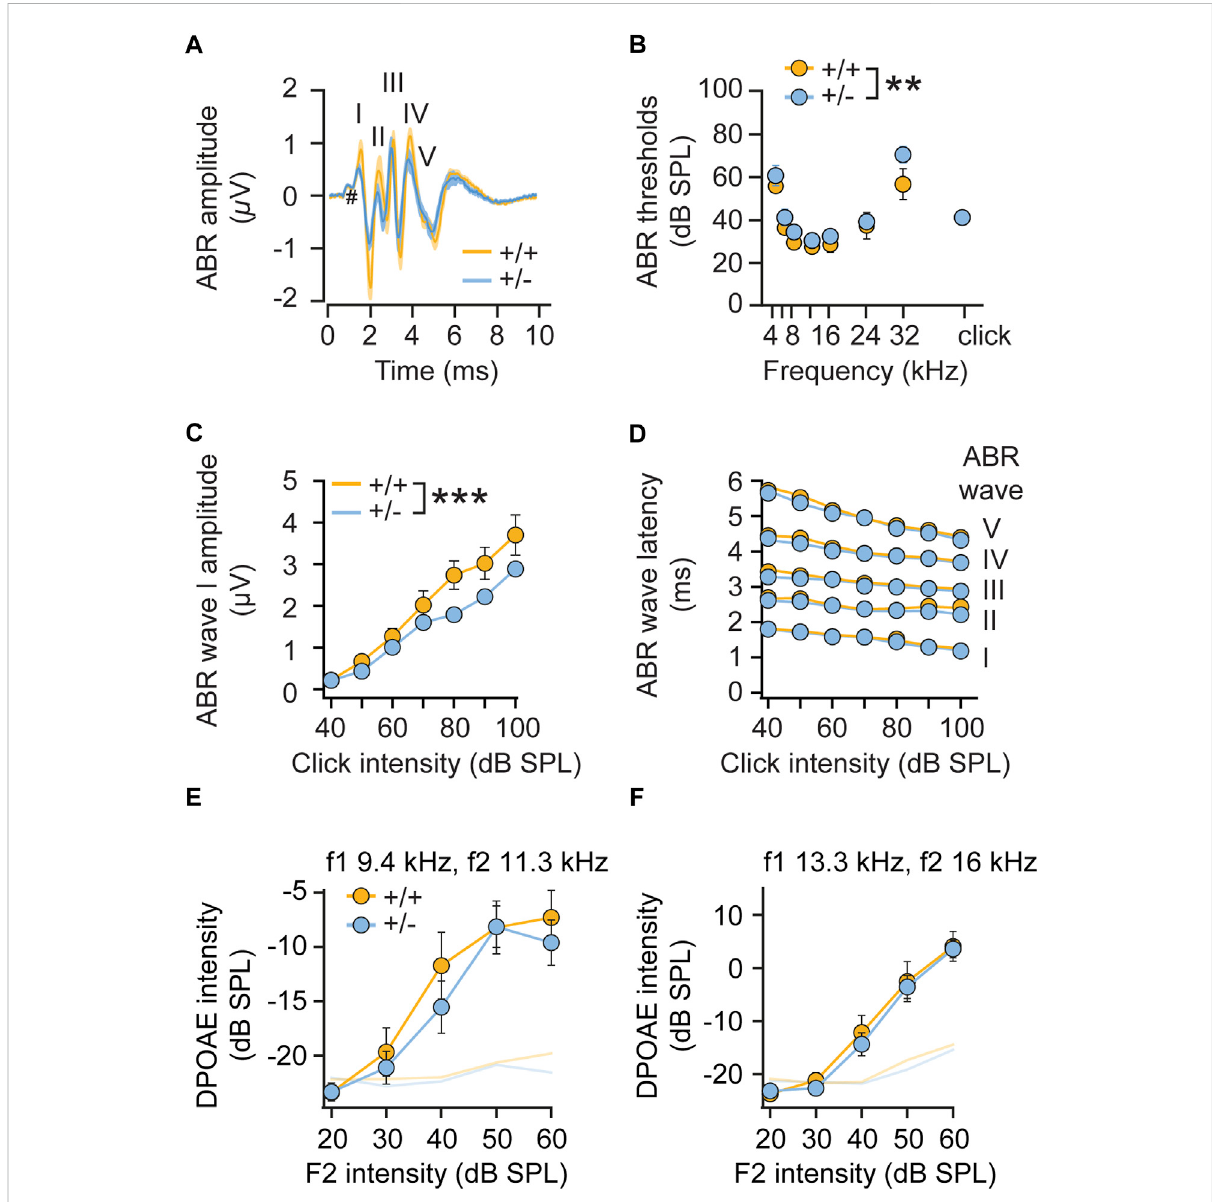
Monoallelic loss of radixin only minimally affects hearing function. (A) ABR waveforms to a 80-dB click stimulation in adult (+/+) and (+/-) rdx mice(grandaverages±SEM, n =10each)arewellpreserved.RomannumeralsontopdesignateABRwaves;#indicatesthesummatingpotential. (B) ABRthresholdstotoneburststimulationareslightlyelevatedin rdx (+/-)mice( p =0.0074,2-wayANOVAacrossalltoneburstfrequencies; p =0.08, independentStudent ’ st-testforclicks). (C) ABRwaveIamplitudeisslightlyreducedin rdx (+/-)mice( p < 0.0001,2-wayANOVA). (D) Analysisof ABR latencies show no differences across genotypes. (E,F) Analysis of DPOAE growth functions (shown for f1 9.4 kHz, f2 11.3 kHz (E) and f1 = 13.3kHz/f216 kHz (F) ,L2=L1-10)revealed nosigni fi cant differencesacrossgenotypes. n =10micepergenotype.2-way ANOVAwasusedto